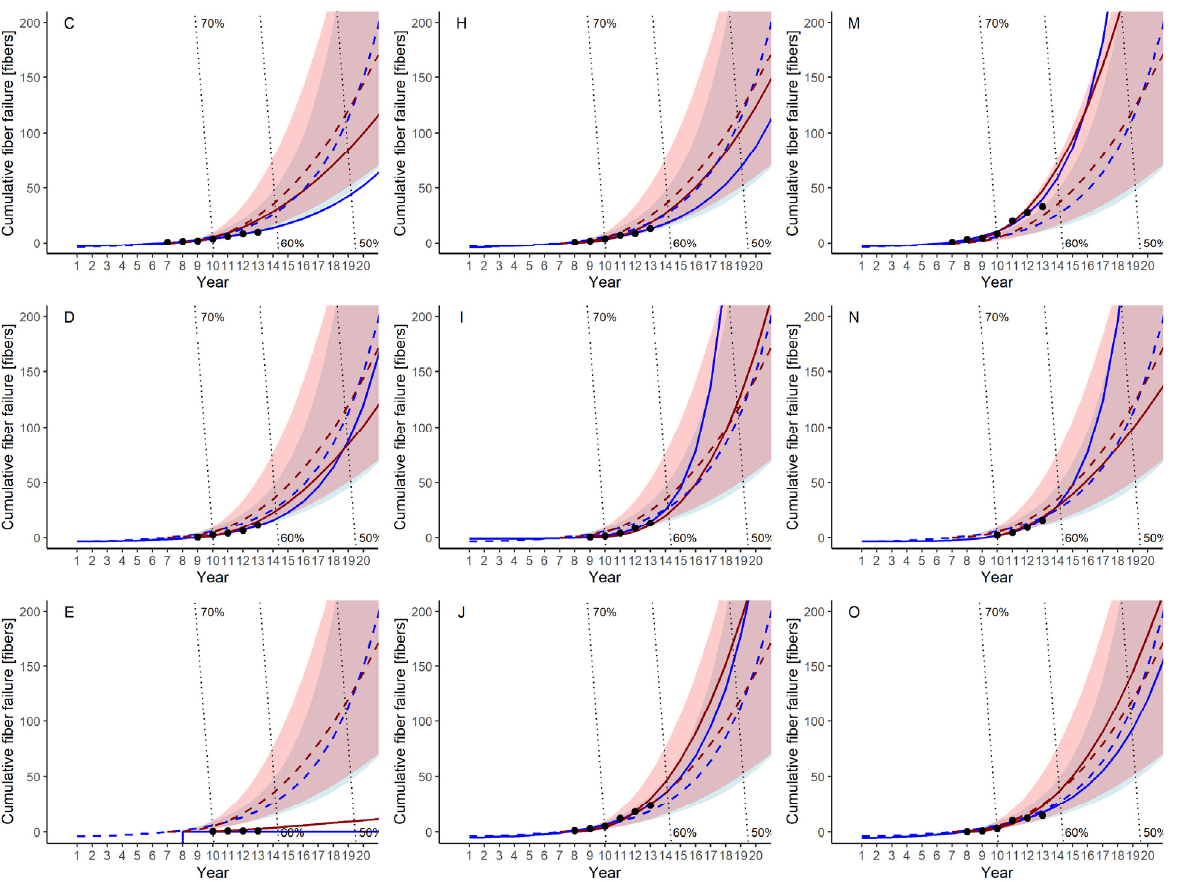
Figure 5. Cumulative failure for each membrane module. Train 1: ( A – E ), Train 2: ( F – J ), and Train 3: ( K – O ). Solid lines indicate curves fit by the power law NHPP model (red) and the log-linear NHPP model (blue), and dashed lines indicate the curves predicted from bootstrapped parameters.